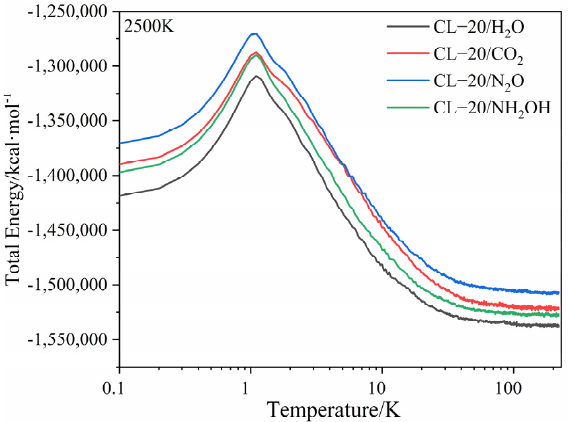
Figure 4. The total energy of CL − 20/H 2 O, CL − 20/CO 2 , CL − 20/N 2 O, CL − 20/NH 2 OH systems with time at 2500 K. Thick trendline corresponds to the actual concentration data of corresponding matching color.